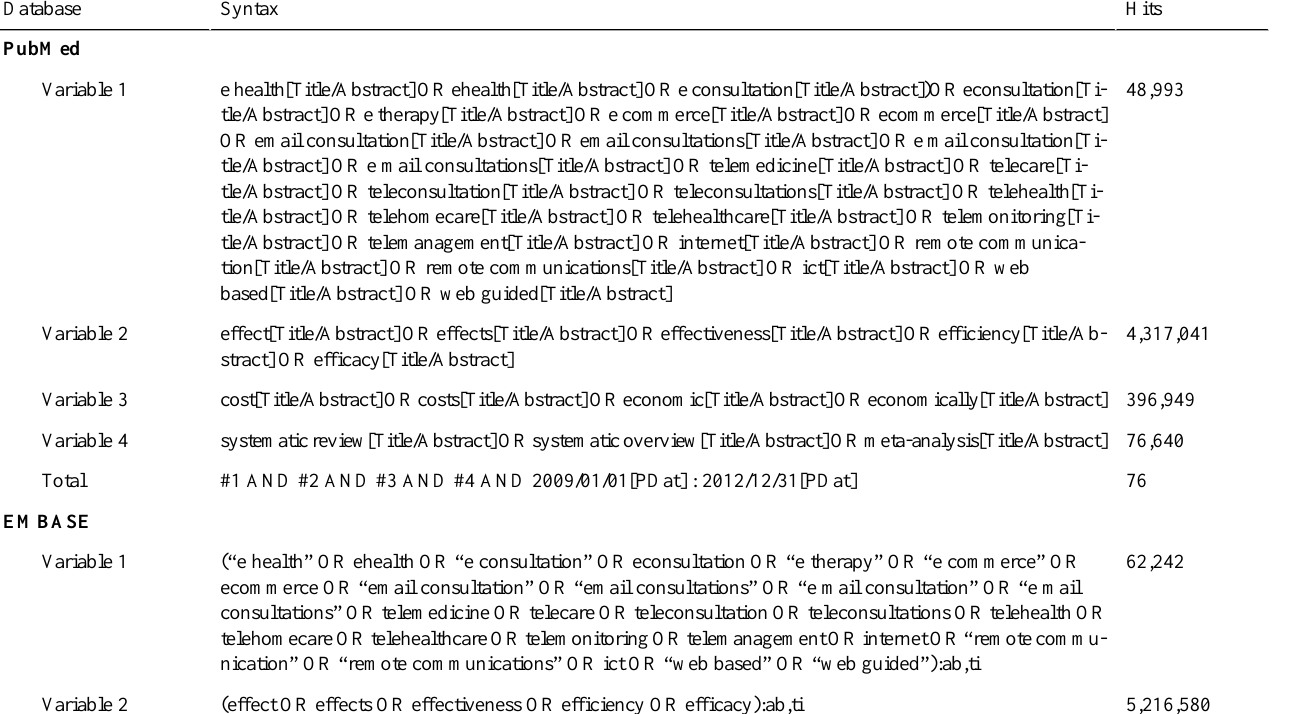
Table 2. PubMed, EMBASE, The Cochrane Library, and Scopus search queries for systematic reviews and meta-analyses on the cost-effectiveness of eHealth interventions (search conducted on September 12,